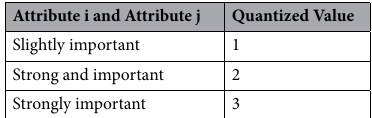
Table 2. Importance